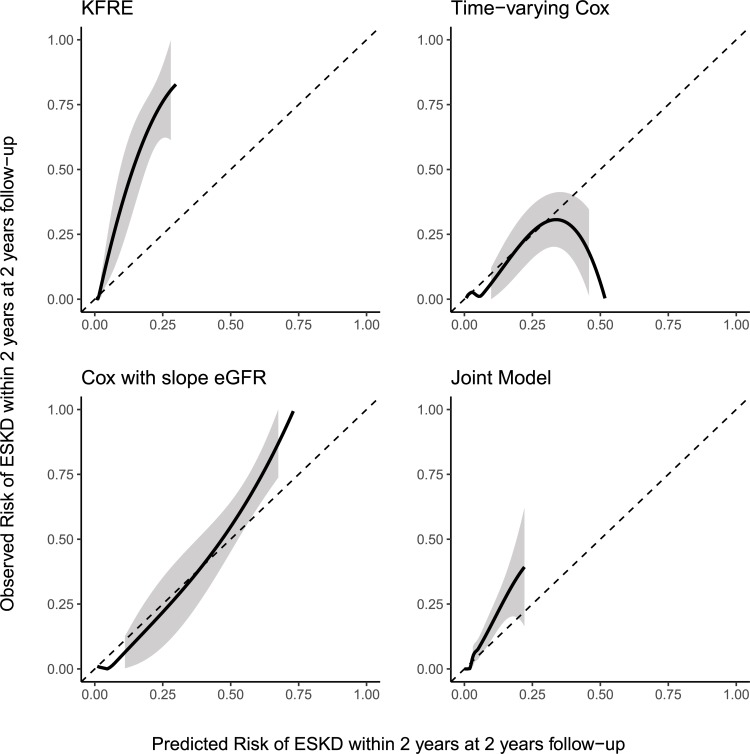
Calibration between predicted and observed risk of progression to end-stage kidney disease at five years follow-up in the NephroTest cohort.The black line indicates the average calibration line, the shaded area is the 95% confidence interval. The Kidney Failure Risk Equation (KFRE) was implemented without any re-estimation or recalibration. The other models were trained on the MASTERPLAN data and were used without re-estimation or recalibration to predict progression to end-stage kidney disease within the next 2 years (i.e. horizon h = 2) at 2 years of follow-up (i.e. landmark time t = 2).